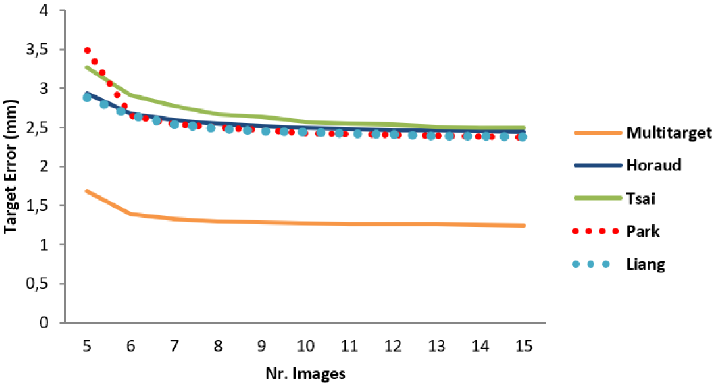
Fig 12. Target registration error trend at the scanning depth of 15 cm. Like the previous measurements, the Multi- target method (orange line) had target error lower than the Hand-eye.